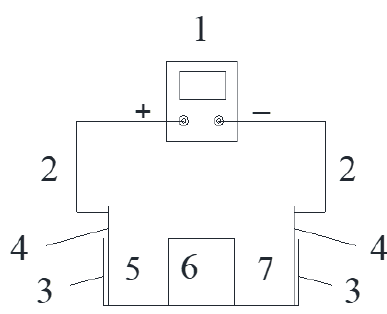
Figure 1. Test process of stray current.